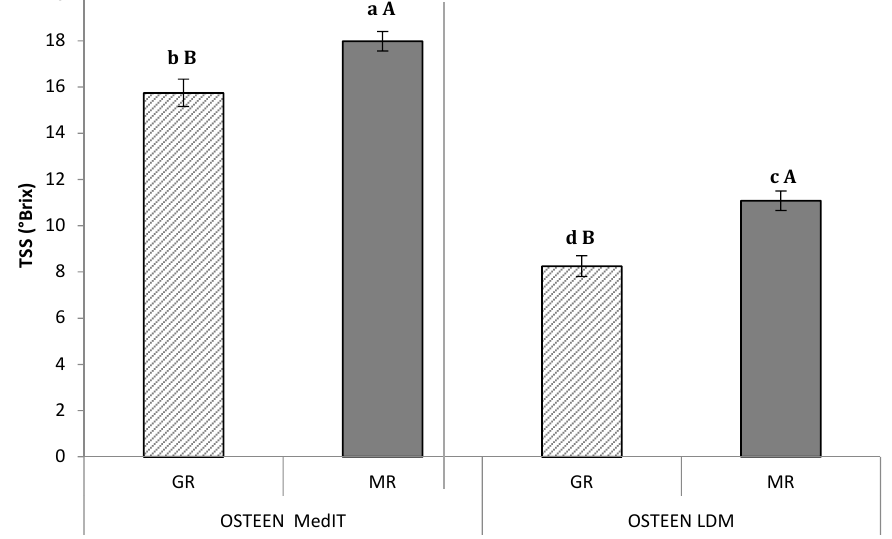
Figure 3. Evolution of Total Soluble Solids (TSS) in green-ripe (GR) and mature-ripe (MR) fresh Mediterranean Italian (MedIT) and imported (LDM) “Osteen” mango fruit. Values represented as mean ± SE ( n = 30). Di ff erent lowercase letters indicate significant di ff erences between imported and fresh Mediterranean Italian mango fruit (GR and MR). Di ff erent uppercase letters indicate significant di ff erences between mature-green (GR) and mature-ripe (MR) stages in the same series, fresh Mediterranean Italian fresh mango fruit or imported (Osteen MedIT or Osteen LDM).